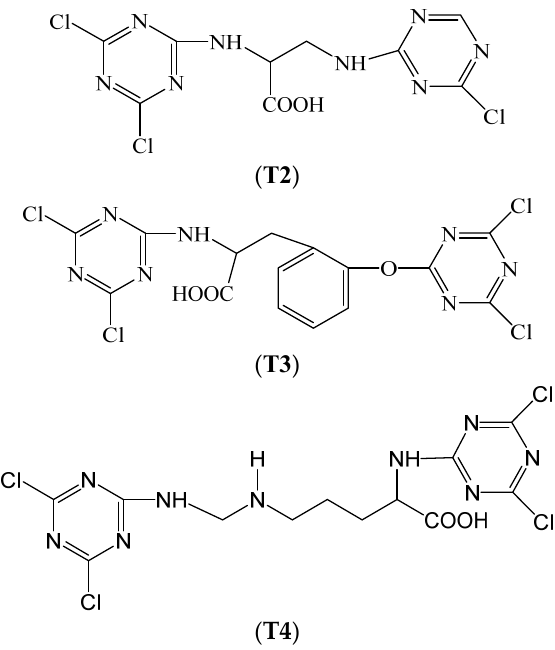
Figure 1. Basic structure of non-metallic organic tanning agents (NOTAs).